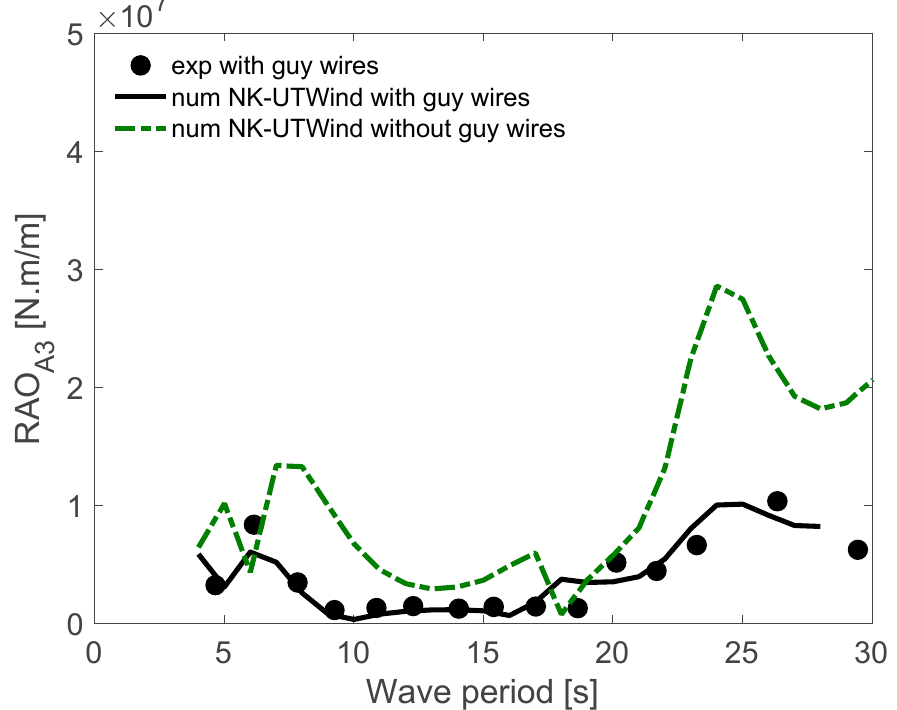
Figure 24. Effect of the guy wires on the RAO bending moment at the side pontoon gage (A3), and its comparison between the experiment and calculation.